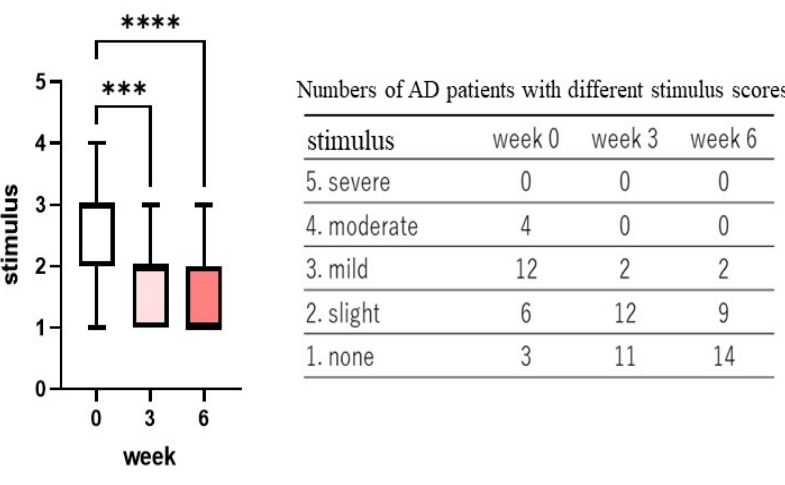
Figure 5. Clinical effects of the POLG nano-emulsion on stimulus sensations of the skin of AD patients. Stimulus sensations were assessed by a dermatologist (KN) after querying each subject at 0, 3, and 6 weeks, and were scored on a 1–5 grading basis (1 = none; 2 = slight; 3 = mild, 4 = moderate; 5 = severe). n = 25; ***: p < 0.001, ****: p < 0.0001 compared to week 0; all data were analyzed using Dunn’s multiple comparisons